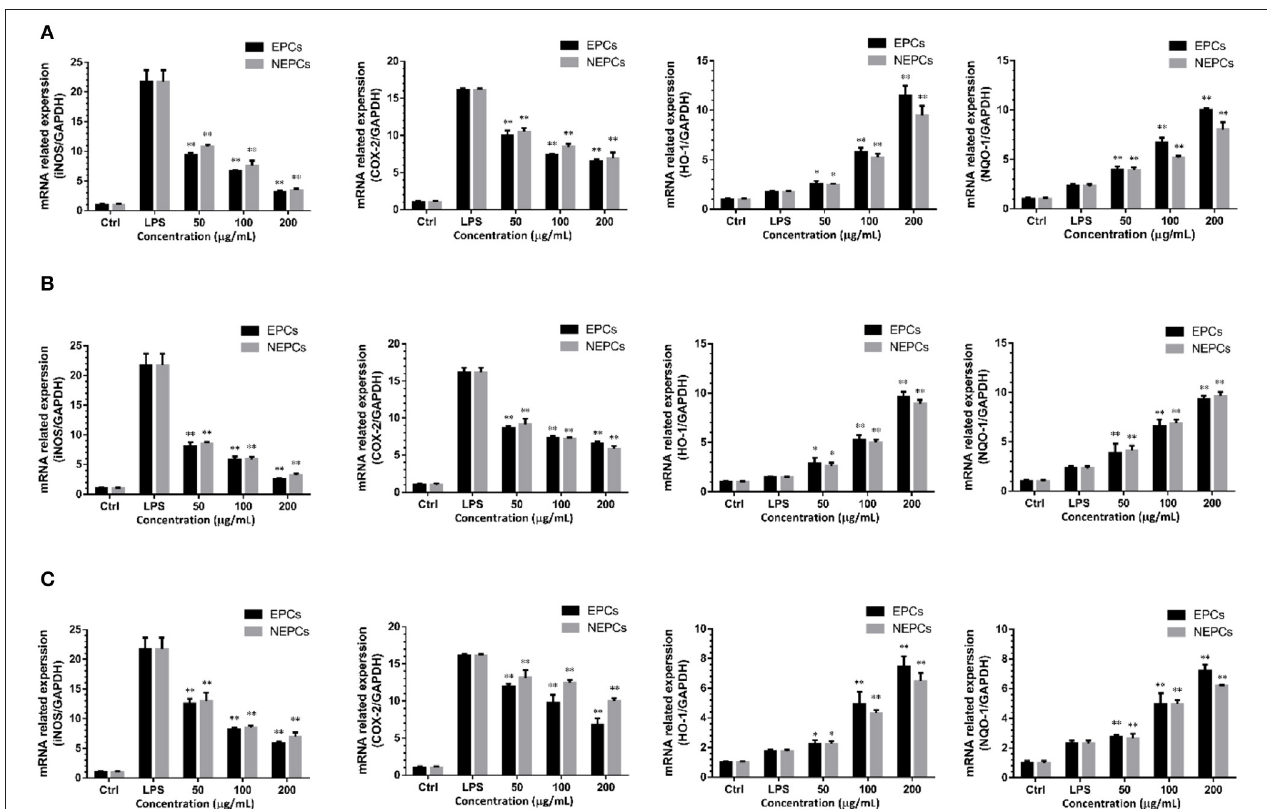
FIGURE 4 | Effects of EPCs and NEPCs from L. japonica (A) , U. lactuca (B) , P. tenera (C) on mRNA expression of iNOS, COX-2, HO-1 and NQO-1 in activated macrophages. Results were expressed as mean ± SD ( n = 3), * p < 0. 05 and ** p < 0.01 indicate statistically differences from LPS-treated